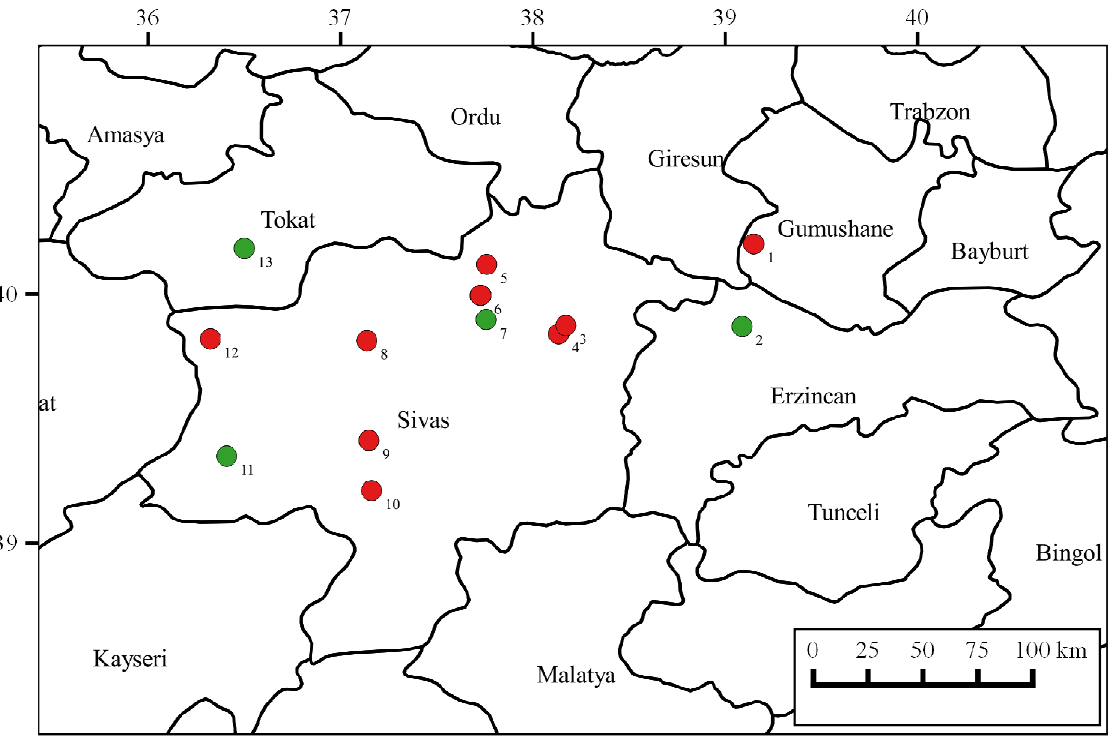
F IGURE 1. Mapped localities with sufficient geographical information. Red: author’s observations; Green: other sources (see table 1). 1: Şiran E, 2: Sakaltutan Geçidi, 3: İmranlı E, 4: Bulgurluk, 5: Şerefiye, 6: Kösedağ, 7: Zara, 8: Seyfebeli Geçidi, 9: Kayapınar W, 10: Mısırören, 11: Şarkışla Kümbet Köyü, 12: Karakaya E, 13: Tekneli Köyü. D